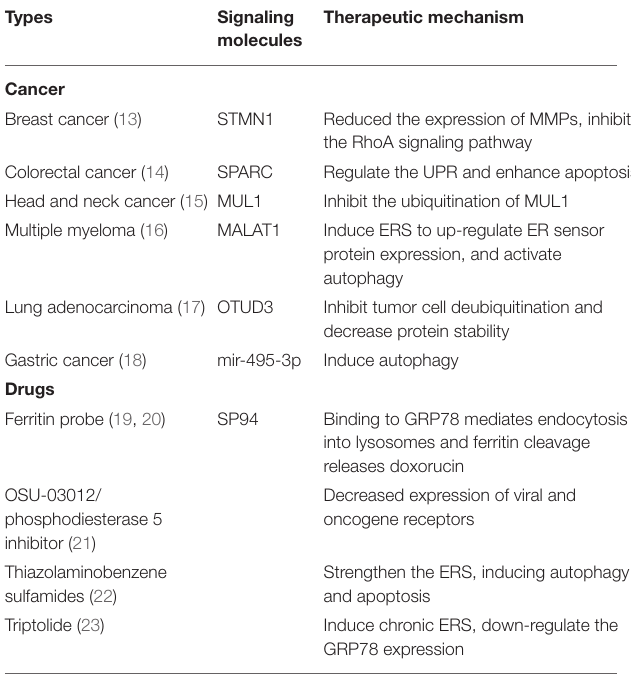
TABLE 1 | The specific mechanisms of cancer and therapy